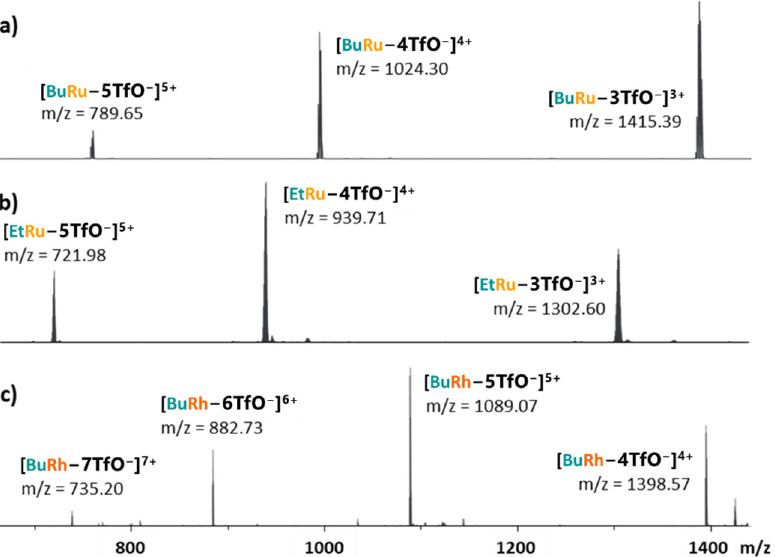
Figure 3. ESI-FTICR mass spectra recorded in methanol (C = 10 − 4 M) of: ( a ) BuRu ; ( b ) EtRu ; and ( c ) BuRh . The 1 H NMR, 1 H COSY NMR and 1 H DOSY NMR spectra of the three cages are